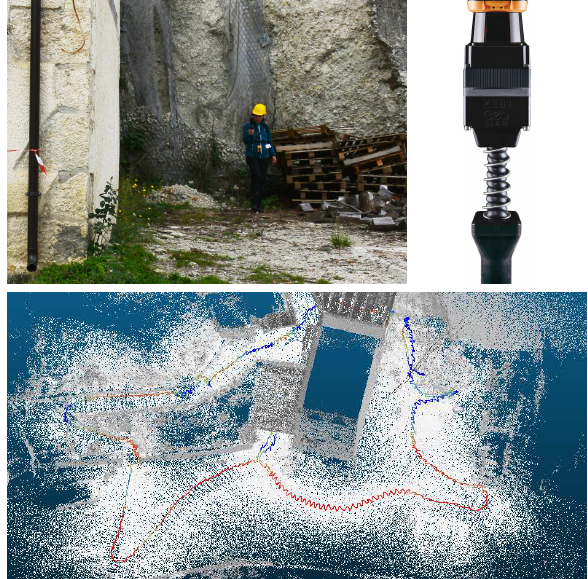
Figure 4 Zeb 1 by Geo-Slam: an acquisition moment (left), the instrument (right). (Down) Geo-Slam path, with quality